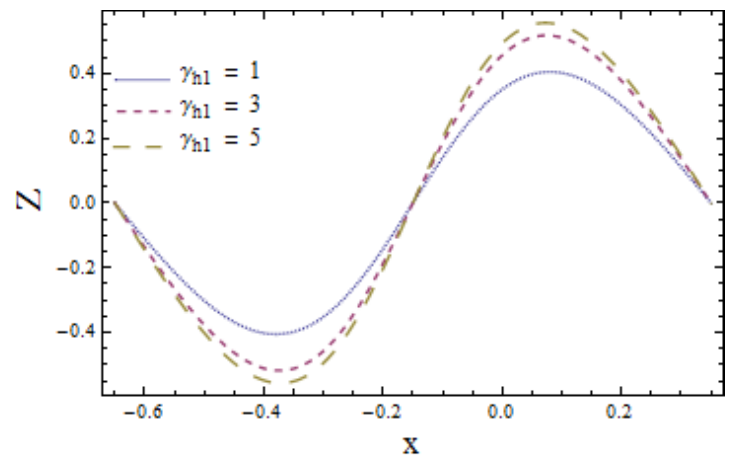
Figure 9. Heat transfer Z versus y for γ h 1 when (cid:101) = 0.2, t = 0.1 and γ h 2 = 8.